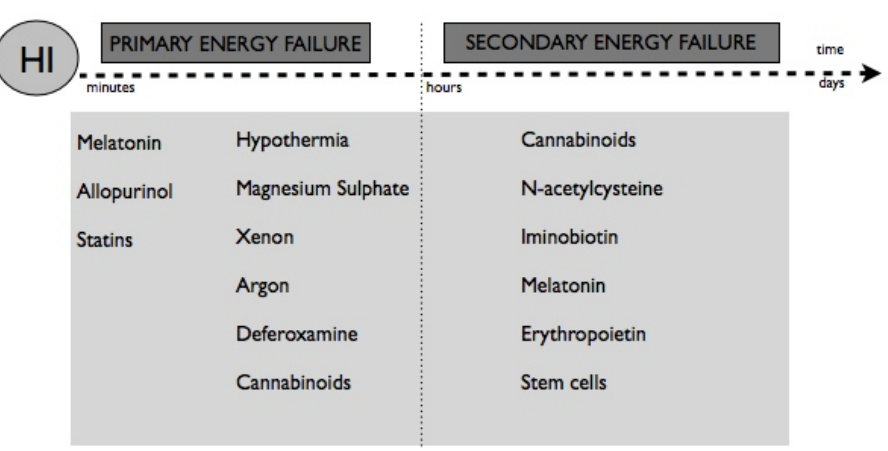
Figure 2. Neuroprotective therapies and their optimal moment of administration, according to their mechanisms of action. In this sense, pharmacological antioxidant therapies such as melatonin, allopurinol, hypothermia or magnesium sulfate could be useful just after the HI event. After the reperfusion, when the secondary energy failure takes place, other therapeutic options like cannabinoids, erythropoietin or iminobiotin, which have anti-inflammation and anti-apoptotic effects, could be promising